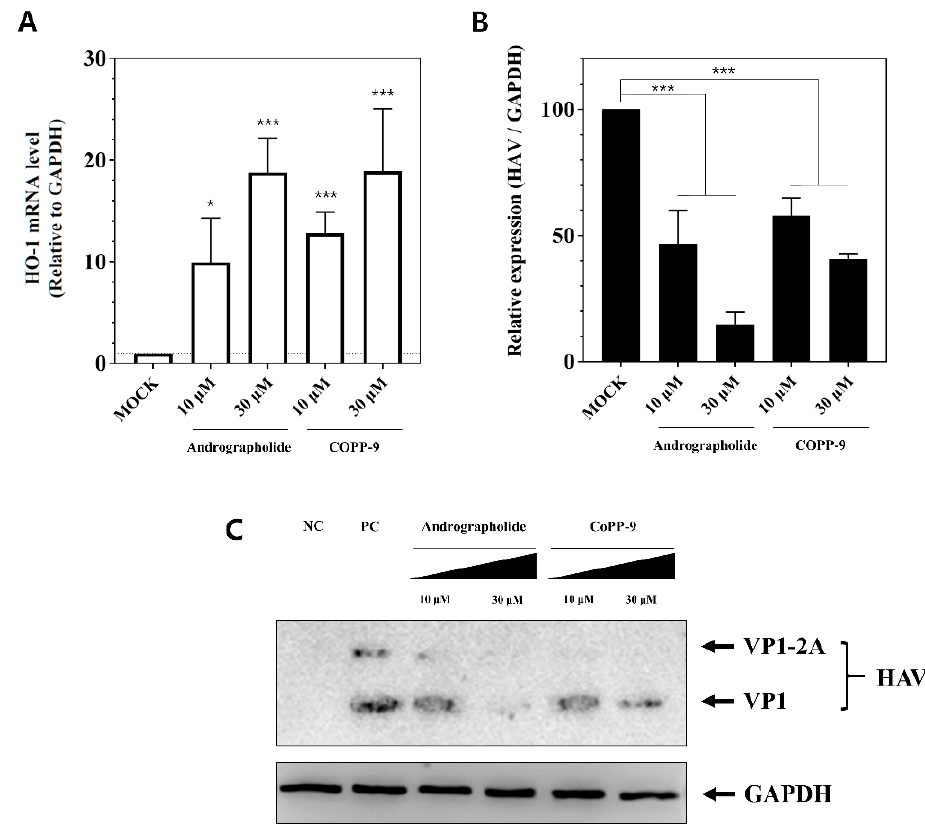
Figure 5. Suppression of HAV replication by other HO-1 inducers, andrographolide and CoPP-9. Non-porphyrin-derived HO-1 inducer (andrographolide) or another porphyrin derived HO-1 inducer (CoPP-9) were used to prove that the inhibition of HAV replication was not caused by other action of hemin. ( A , B ) Andrographolide and CoPP-9 also could significantly increase HO-1 mRNA and suppress HAV RNA replication depending on the concentration. ( C ) HAV VP1 proteins decreased depending on the concentration. Data are presented as the mean ± standard deviations (SD) of at least 3 independent experiments. * p < 0.05; *** p < 0.001.